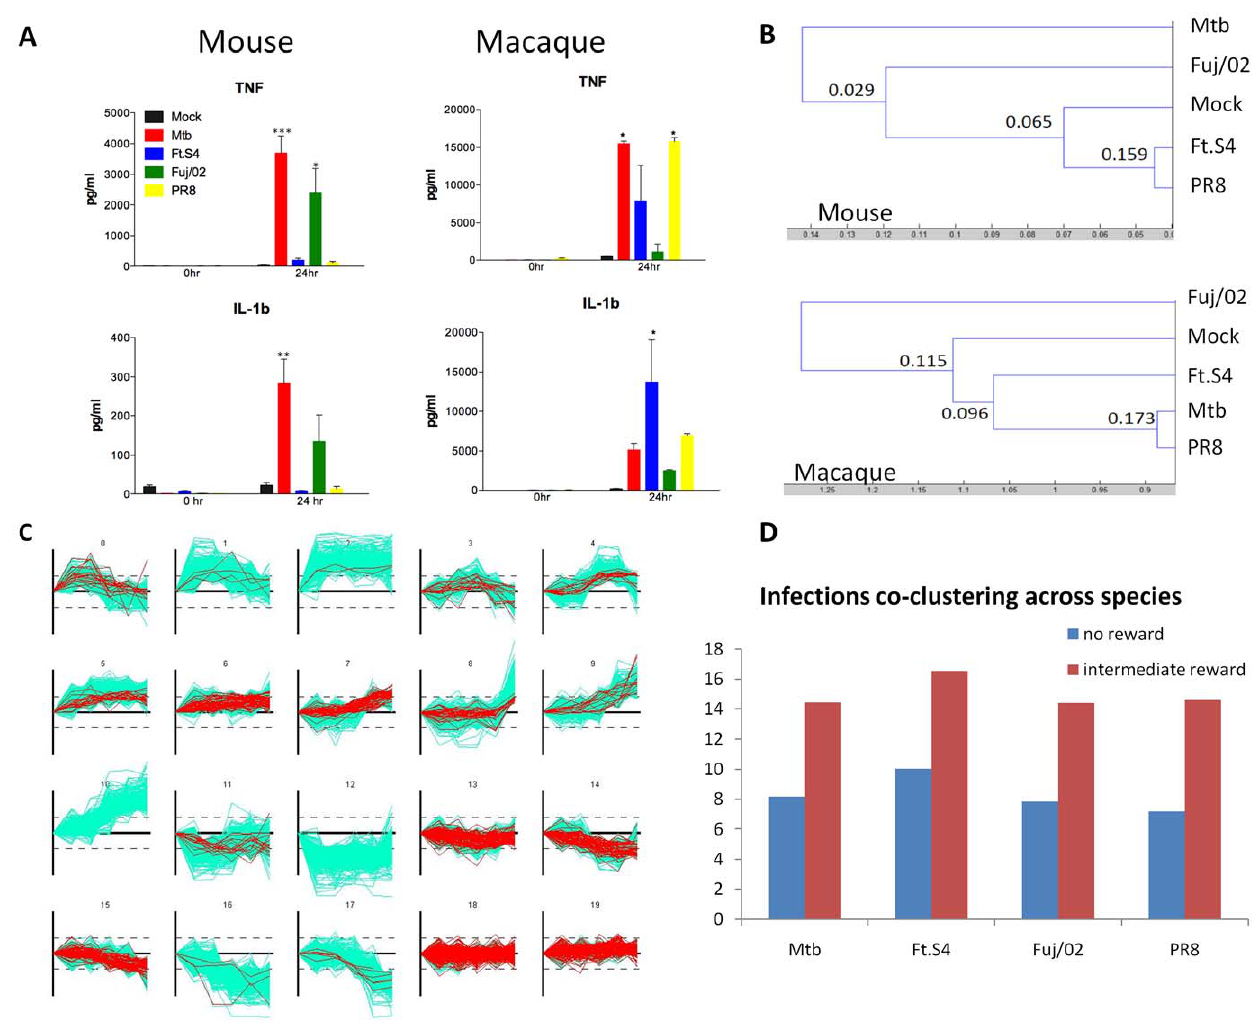
Figure 1. Pathogens that give rise to lethal infections invivo elicit weak responses from AM. (A) AM from C57BL/6 mice or cynomolgus macaques were exposed to the indicated pathogens. Supernatants were collected at 0 hr and 24 hr following exposure and examined for the production of TNF and IL-1 b by Luminex as described in the Methods. Results are expressed as the mean 6 SEM of 3–8 independent experiments. Statistics were performed using one way ANOVA with a Tukey post test. P values: * , 0.05, ** , 0.01, *** , 0.001. (B) Hierarchical Clustering of differentially expressed (DE) genes from murine (1383 genes) and macaque (1387 genes) AM following exposure to the indicated pathogens. The dendrograms were generated as described in Methods. The numbers in the dendrograms represent the frequency with which a particular node was seen in 1000 permutations of the algorithm and gives a level of confidence in the observed structure. (C) Resulting clusters of Softclust analysis over DE genes from all infections in both species. Marked in red are genes that changed cluster assignment following an intermediate orthology reward compared to no-reward run. (D) Infections co-clustering across species in no-reward and intermediate reward settings. Co-clustering increased 82% on average in the rewarded